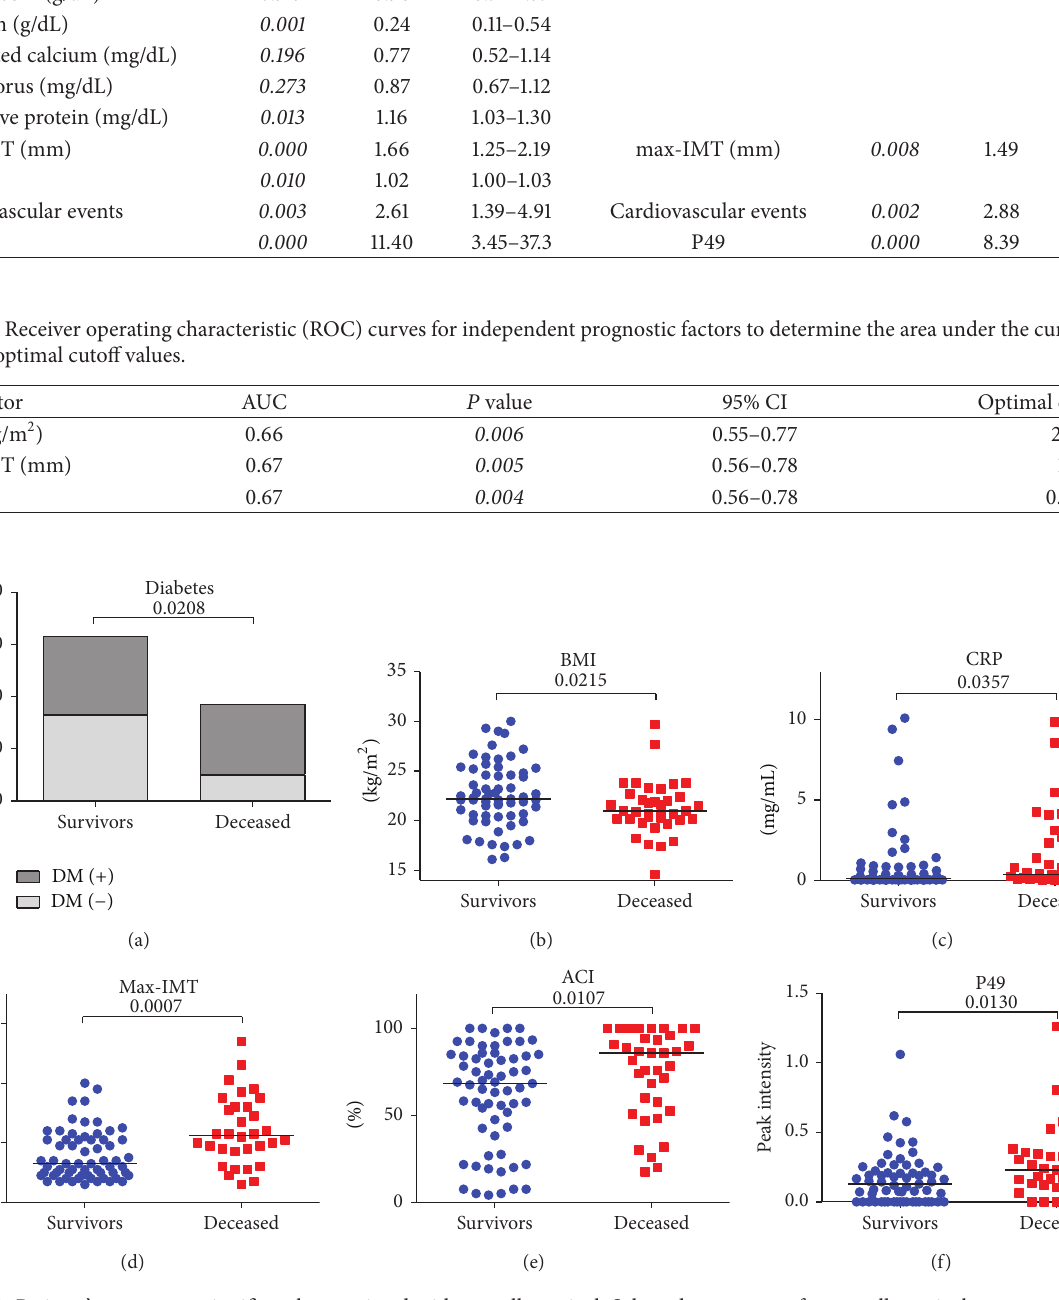
Figure 3: Patients’ parameters significantly associated with overall survival. Selected parameters for overall survival were presence of DM (a), BMI (b), CRP (c), max-IMT (d), ACI (e), and intensity of P49